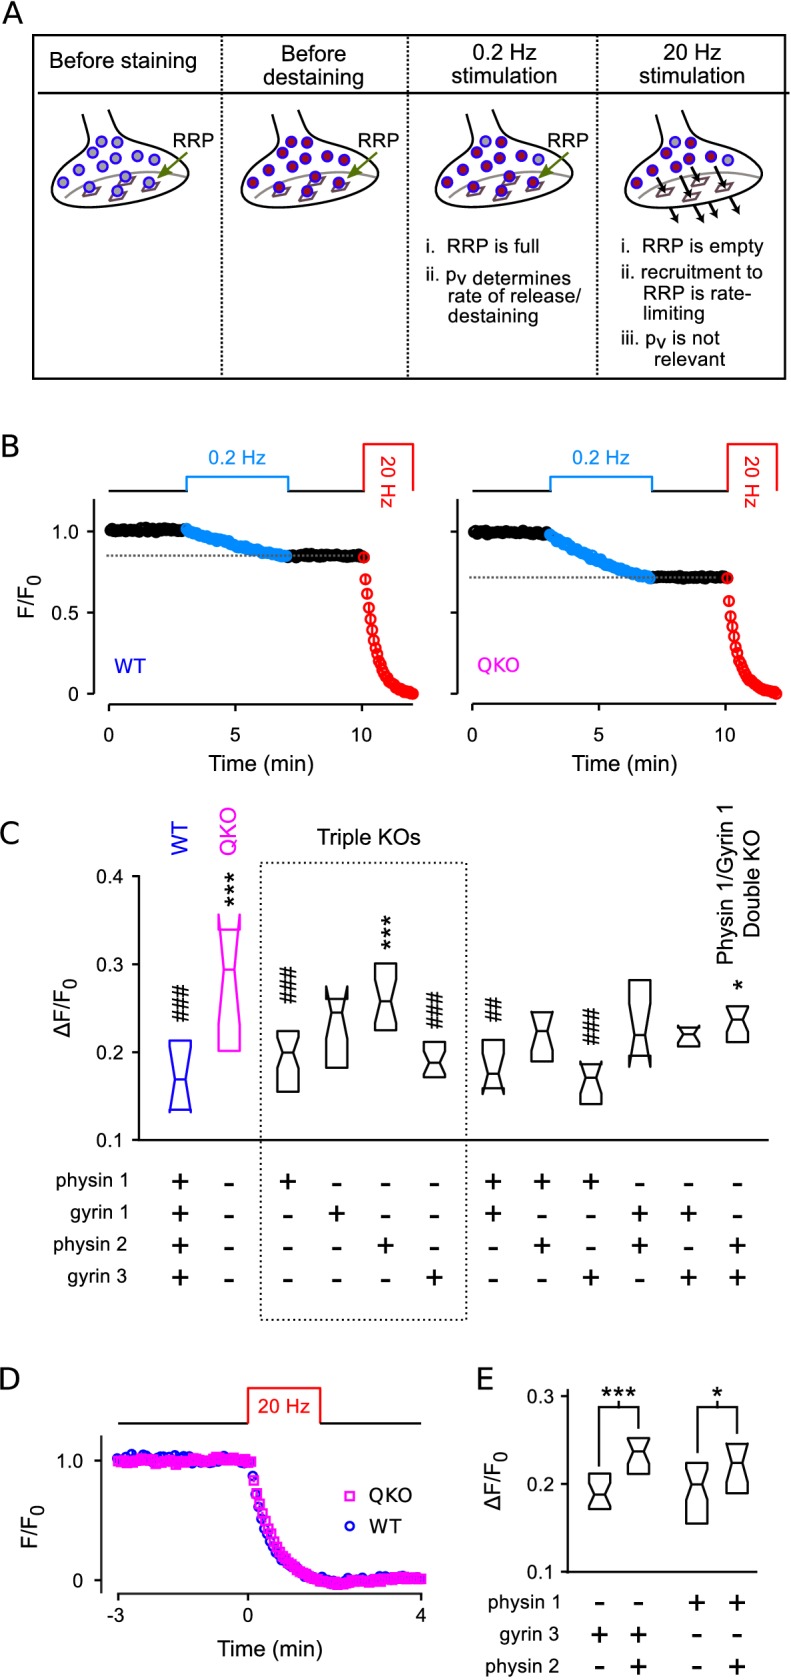
Higher throughput analysis of triple and double knockout synapses.(A) Diagram of concepts. Recycling vesicles are first stained by driving synaptic vesicle exocytosis and subsequent recycling using electrical stimulation in the presence of FM4-64 in the extracellular fluid. Extracellular dye is then removed and dye stuck to the outside of the plasma membrane is washed off. Fluorescence levels are then monitored with time-lapse imaging as synapses are destained by triggering action potentials at low frequency (0.2 Hz). At such a low frequency, the RRP remains almost completely full because the time between action potentials (5 s) is enough for recruitment of new vesicles to replace the ones that undergo exocytosis. Since each action potential releases a higher fraction of the RRP contents at QKO synapses - i.e., because p¯v is higher - more vesicles undergo exocytosis, and destaining is faster as a consequence. In contrast, recruitment to the RRP becomes rate-limiting during high frequency stimulation that is fast enough to drive the RRP to a near empty steady state (20 Hz). As a consequence, the amount of destaining no longer depends on p¯v, and the synaptophysin family proteins no longer influence the timing. (B) Destaining during electrical stimulation for WT and QKO. Data points are mean ± s.e.m. of median values from each preparation; n≥ 11 preparations, each with >250 ROIs. Δ⁢F/F0 values in (C and E) are calculated as 1 minus the value indicated by the horizontal dashed line. (C) Comparison across genotypes of amount of destaining during the 0.2 Hz train of stimulation. Experimenter was blind to genotype. Boxes are middle two quartiles; horizontal lines are medians; notches signify 95% confidence intervals (***p<0.001, *p<0.05, compared to WT; ###p<0.001, ##p<0.01, compared to QKO; ANOVA followed by Tukey’s honest significant difference criterion; n≥ 11 for each). (D) No difference between WT and QKO in time course of destaining when the frequency of stimulation was 20 Hz; n ≥3 preparations. (E) Follow-on paired tests indicate that synaptophysin 2 lessens the amount of compensation produced by synaptogyrin 3 or synaptophysin 1 when expressed alone (***p<0.001, *p<0.05; rank sum).